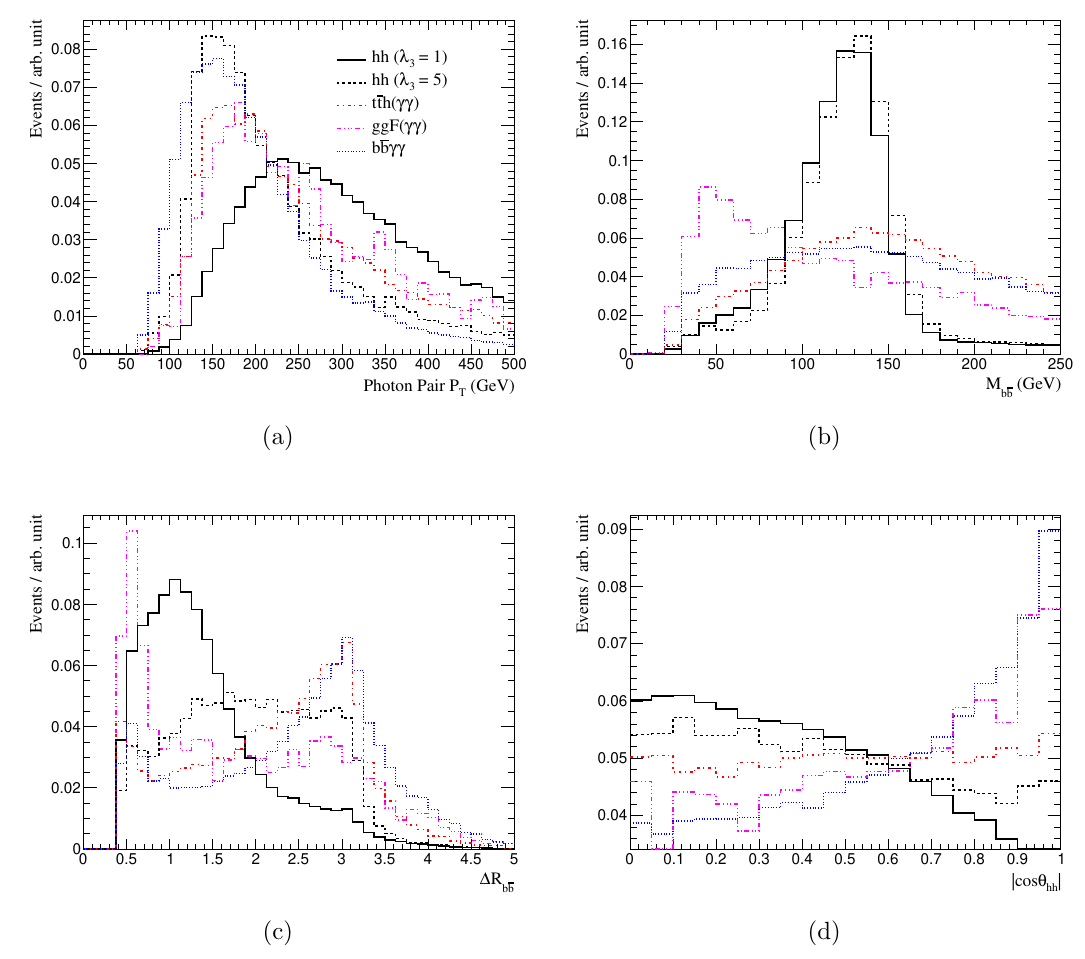
Figure 3. Normalized distributions of (a) the p T of the reconstructed h mass of the h b (cid:22) b pair, (c) angular separation ((cid:1) R ! of cos (cid:18) h , the Higgs decay angle (see text for details). We show the distributions for the SM ( (cid:21)